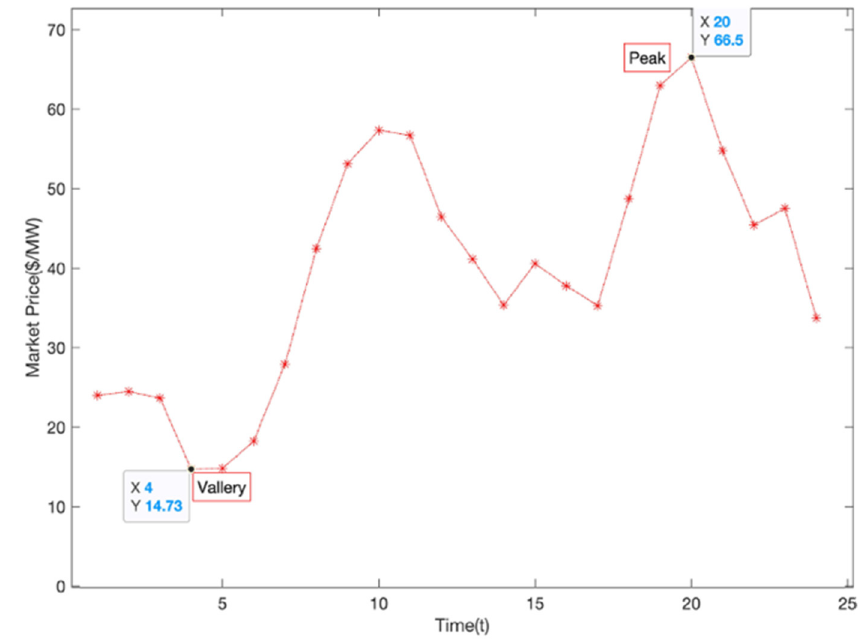
Figure 2. Market price of 11 February 2020 (Data from: EPEX SPOT).